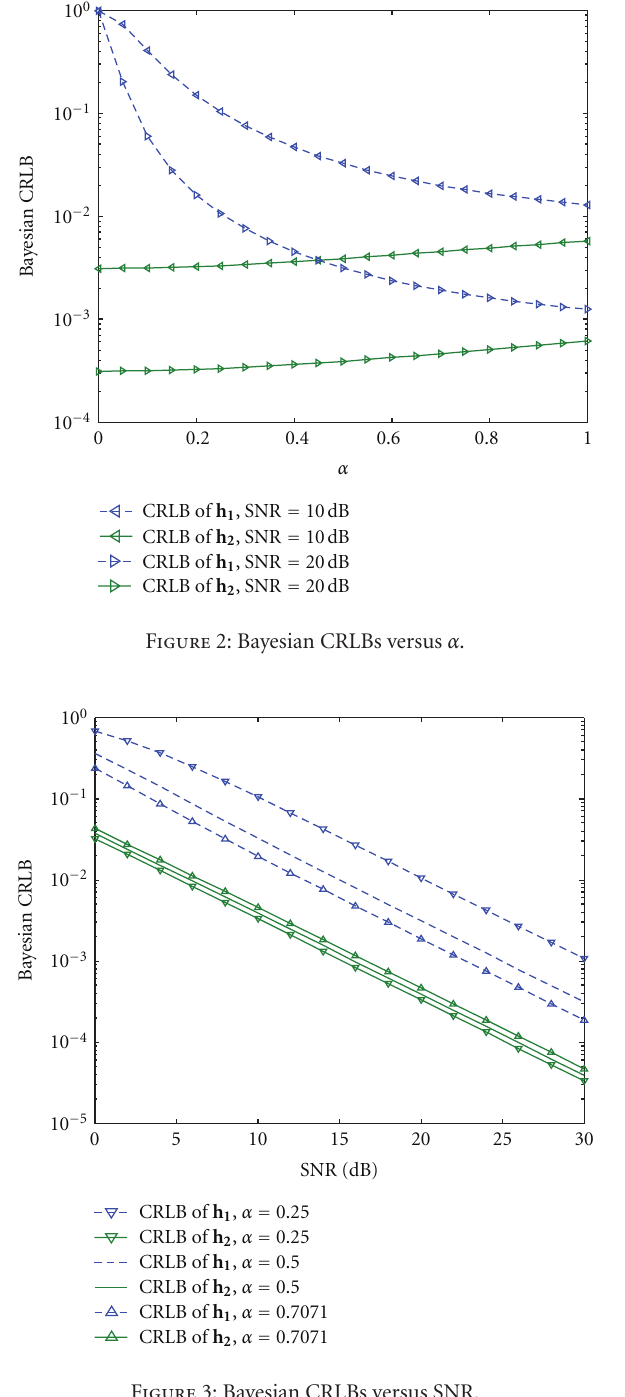
Figure 3: Bayesian CRLBs versus SNR.